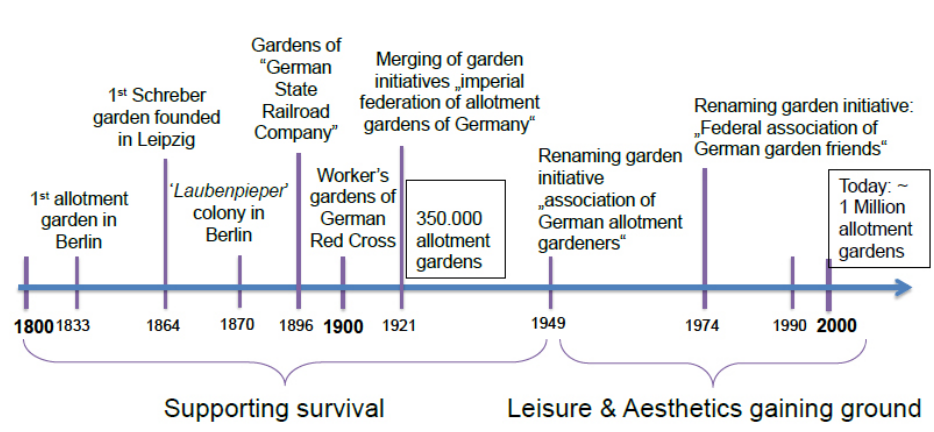
Figure 2. A timeline of allotment gardens.